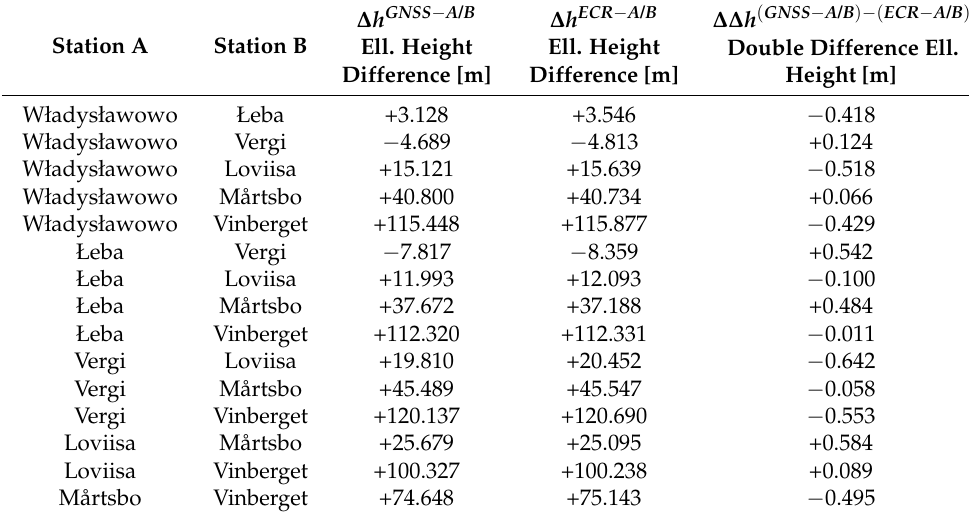
Table 13. Relative (baseline) height differences between ECR stations A and B and co-located GNSS stations A and B and differences of the baseline height differences. GNSS height differences and ECR height differences transferred to the GNSS reference markers are computed with the equation